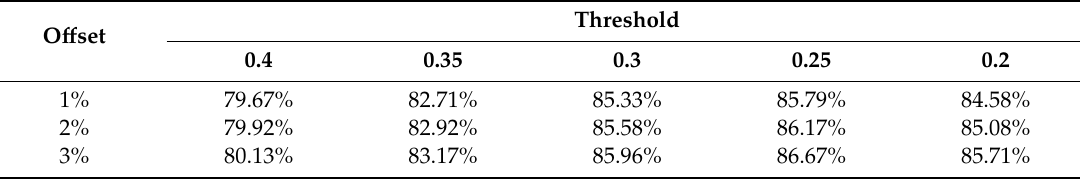
Table 4. Averaged detection probabilities of proposal 1 (window Table 3. Averaged detection probabilities of proposal 1 (window 1).